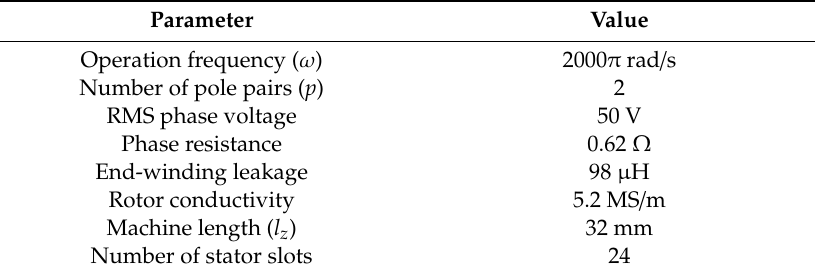
Table 1. Basic specifications of tested induction